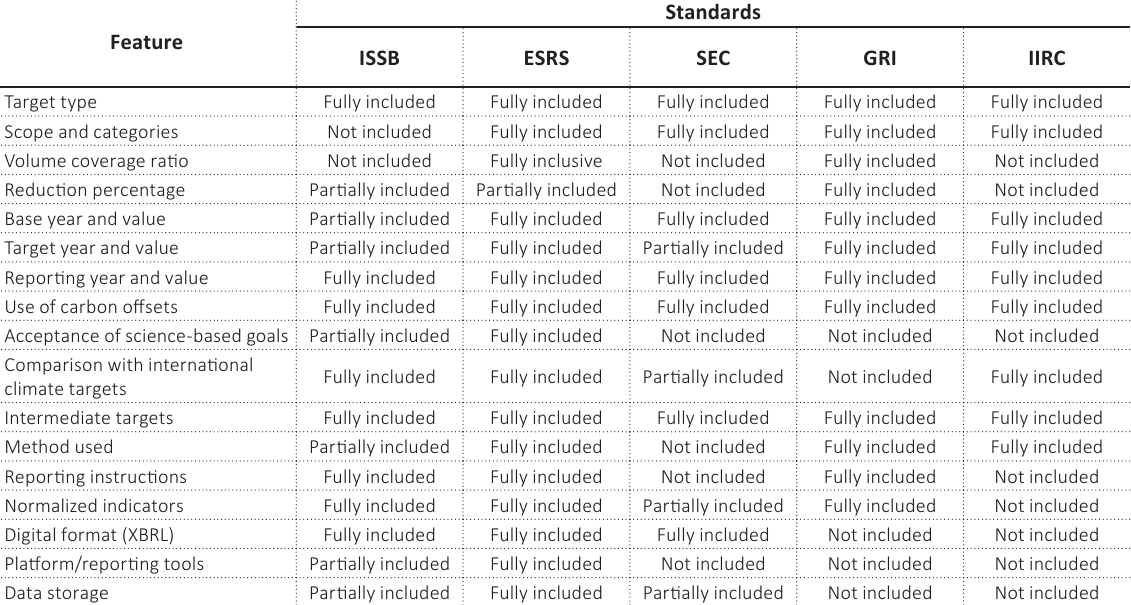
Table 1. Comparative characteristics of disclosure and reporting standards in the field of sustainable